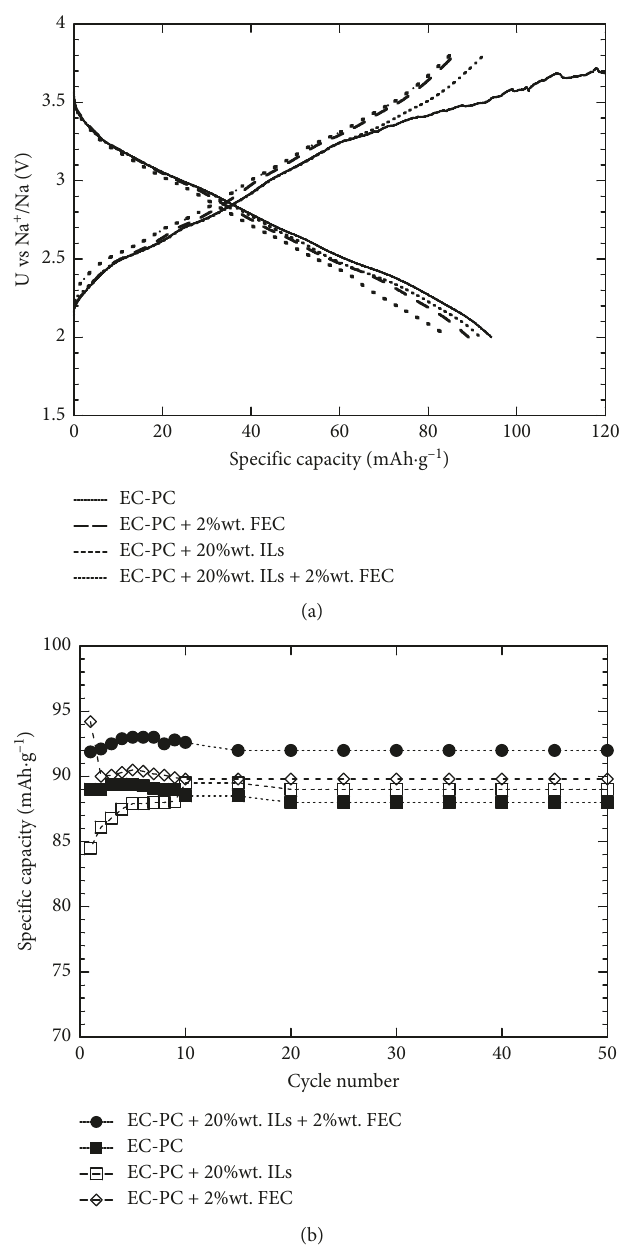
Figure 7: (a) 1 st charge-discharge curve of half-cell (-) Na | EC-PC (1:1)+ x wt.% EMI-TFSI+1M NaTFSI | Na discharge capacity as a function of cycle number at C/10